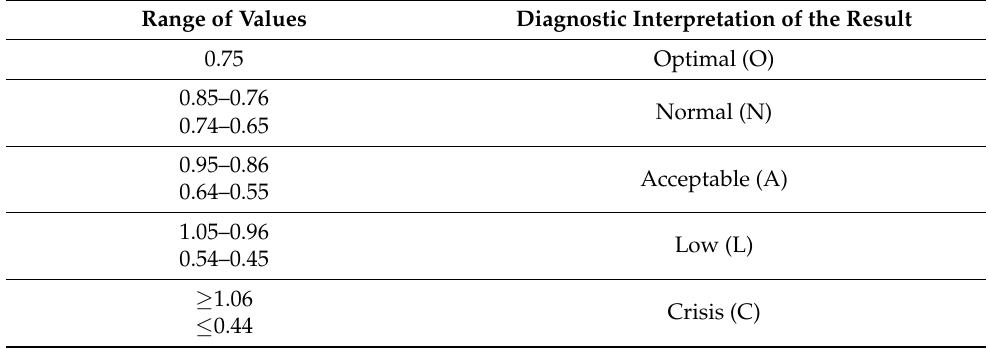
Table 1. The scale of integrated indicator values for enterprise development financial